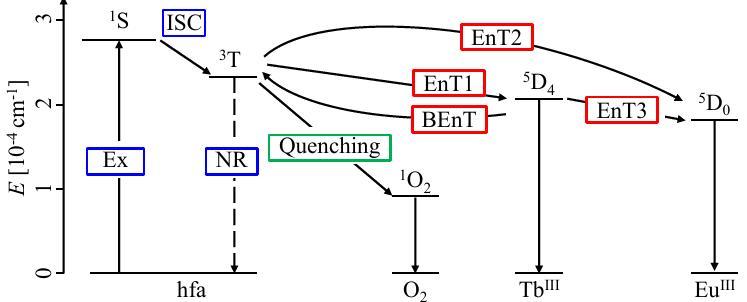
Figure 13. Energy transfer diagram of the chameleon luminophore when oxygen quenching occurs.